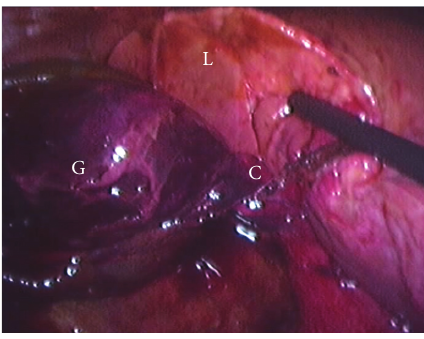
Figure 2: Intraoperative view of gangrenous wandering gallbladder (G) completely separate from the liver (L) and torted clockwise around the cystic duct and mesentery